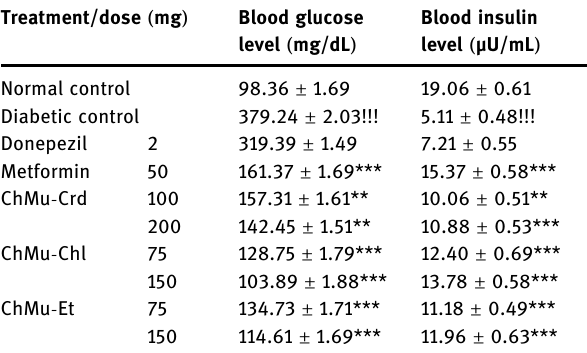
Table 7: E ff ects of crude extract and fractions on blood glucose and insulin level Treatment/dose ( mg